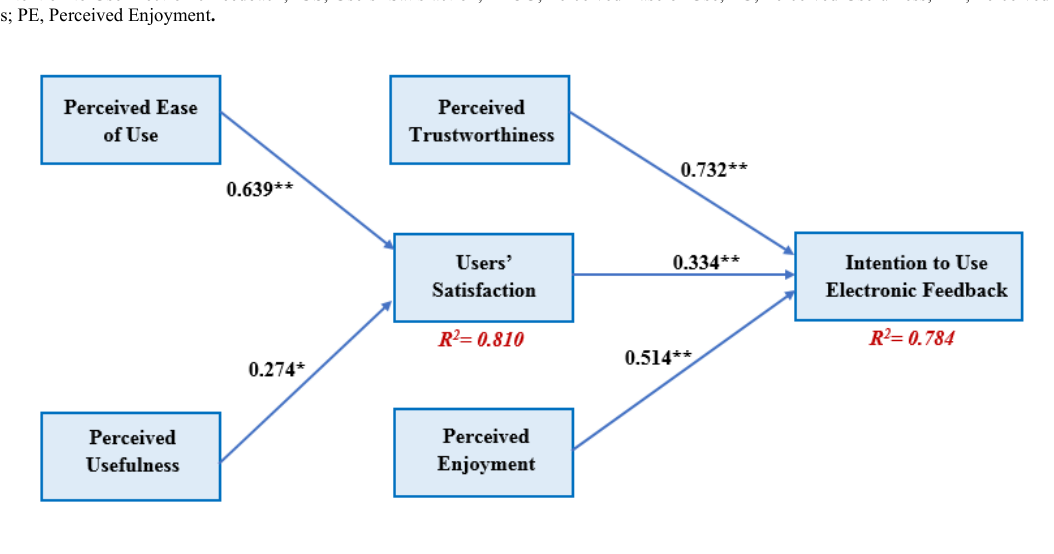
Fig. 2. Path coefficient of the model (significant at p** < = 0.01, p* <